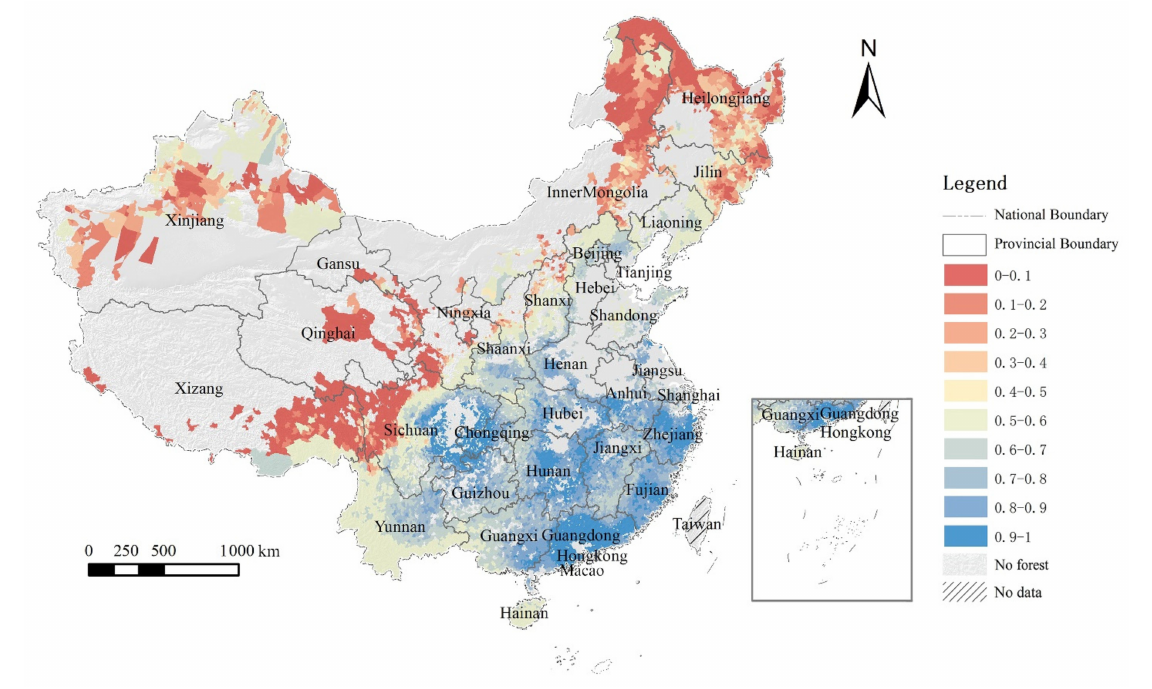
Figure 8. The coordination (CI) of the development of FHBs in